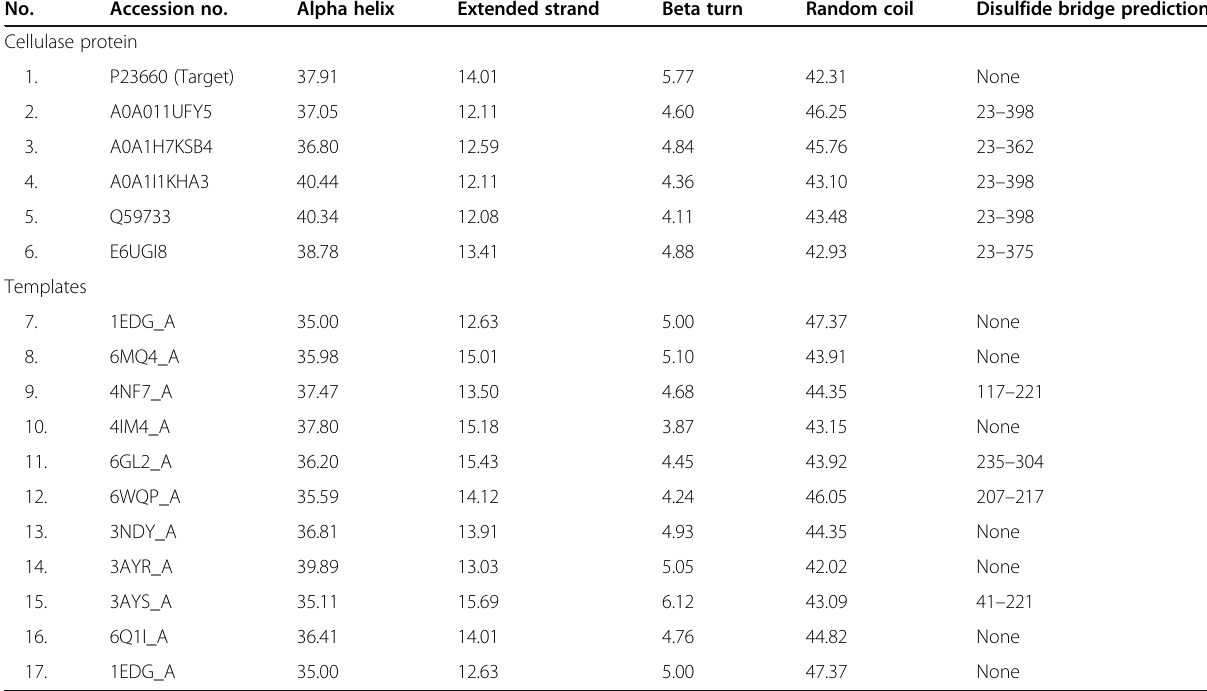
Table 4 Predicted secondary structure content and disulfide bridges from 6 cellulase proteins of Ruminococcus albus strains and from 10 selected template structures No. Accession no. Alpha helix Extended strand Beta turn Random